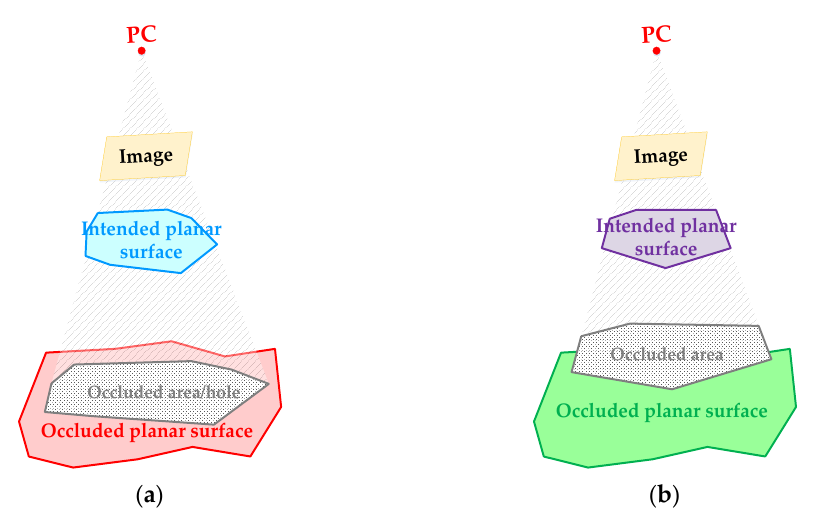
Figure 12. The occlusions caused by the intended planar surface ( a ) all the boundary points of the intended surface projected inside the occluded surface and ( b ) a section of the boundary points projected inside the occluded surface.